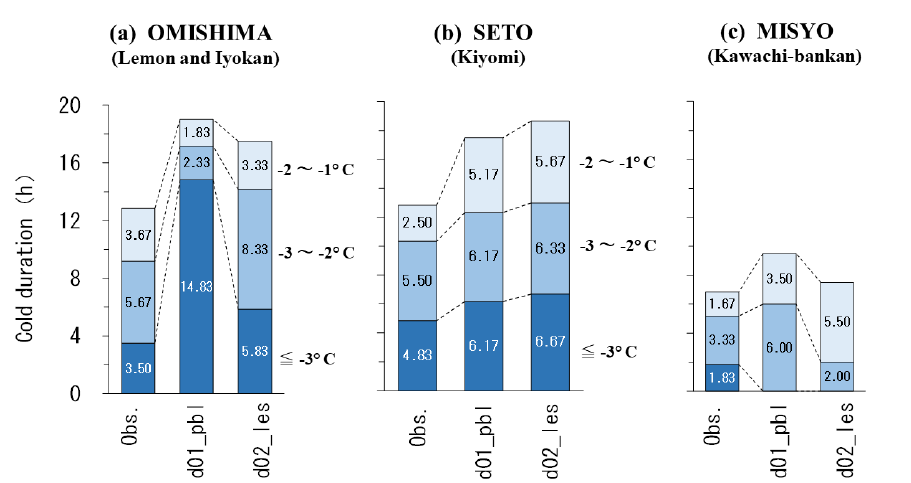
Figure 3. Cold durations (h) recorded between − 2 and − 1 ◦ C, those between − 3 and − 2 ◦ C, and those less than − 3 ◦ C at (a) Omishima, (b) Seto, and (c) Misyo sites by the AMeDAS observation data, simulated d01, and d02 results.